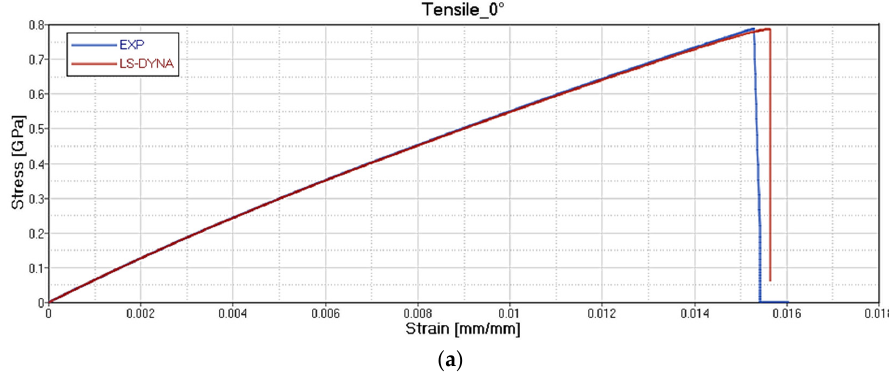
Figure 21. Correlation between experimental data and virtual material card setting for CF/PA66. Tensile test at 0 ◦ (a ); Tensile test at 45 ◦ ( b ) and Force-Displacement (kN-mm) for Bending test at 0 ◦ ( c ).